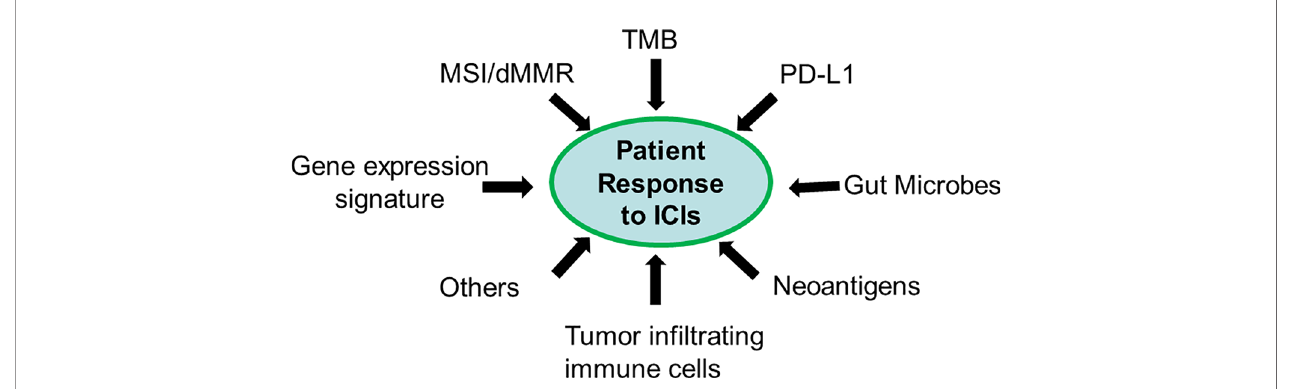
FIGURE 2 | Patient response to ICIs is a quantitative trait. Each biomarker only captures a unique feature of the contributing factor